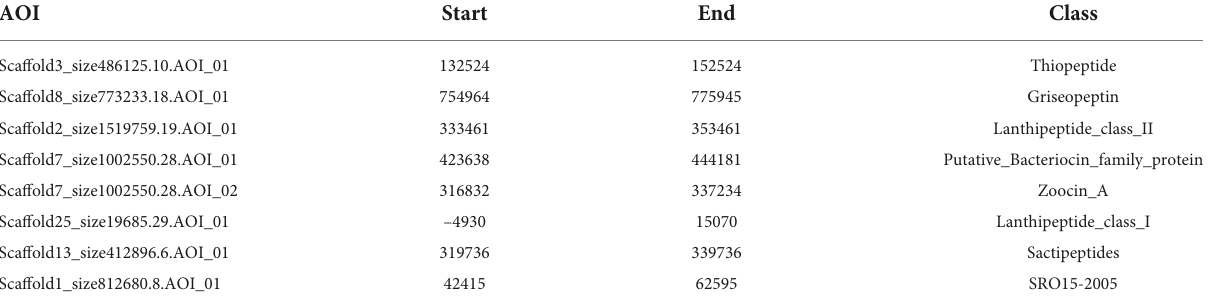
TABLE 6 RiPP and Bacteriocin predicted by